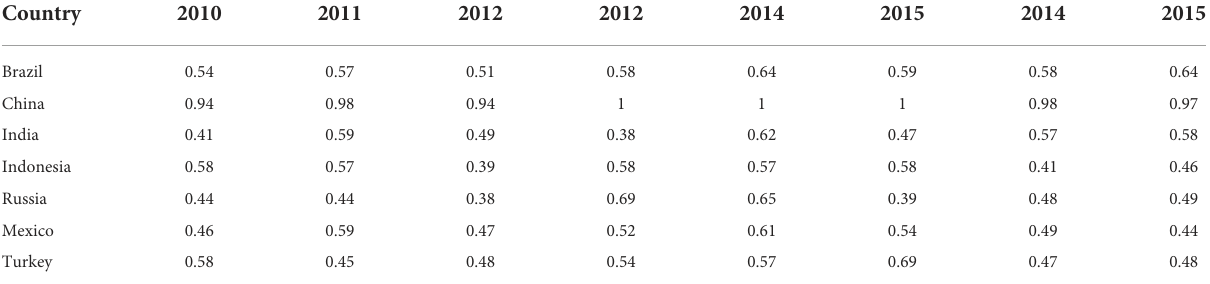
TABLE 9 The green economic performance index. Country